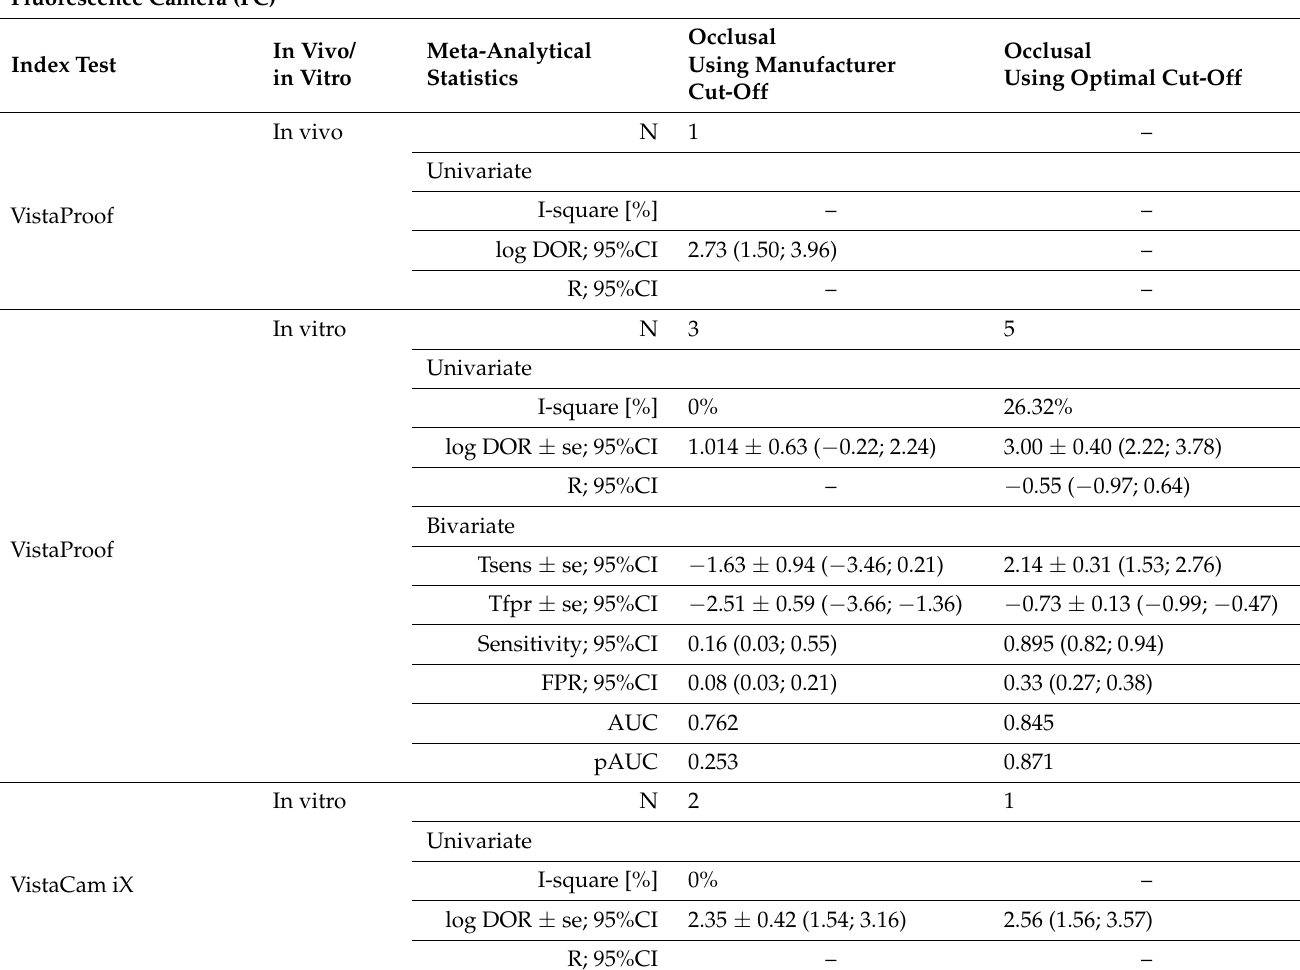
Table 4. Meta-analytical results for FC technology. The five-study sub-group reporting in vitro results by using optimal cut-off values for the VistaProof test, with I-squared = 26.32%, underwent comprehensive meta-analysis (including